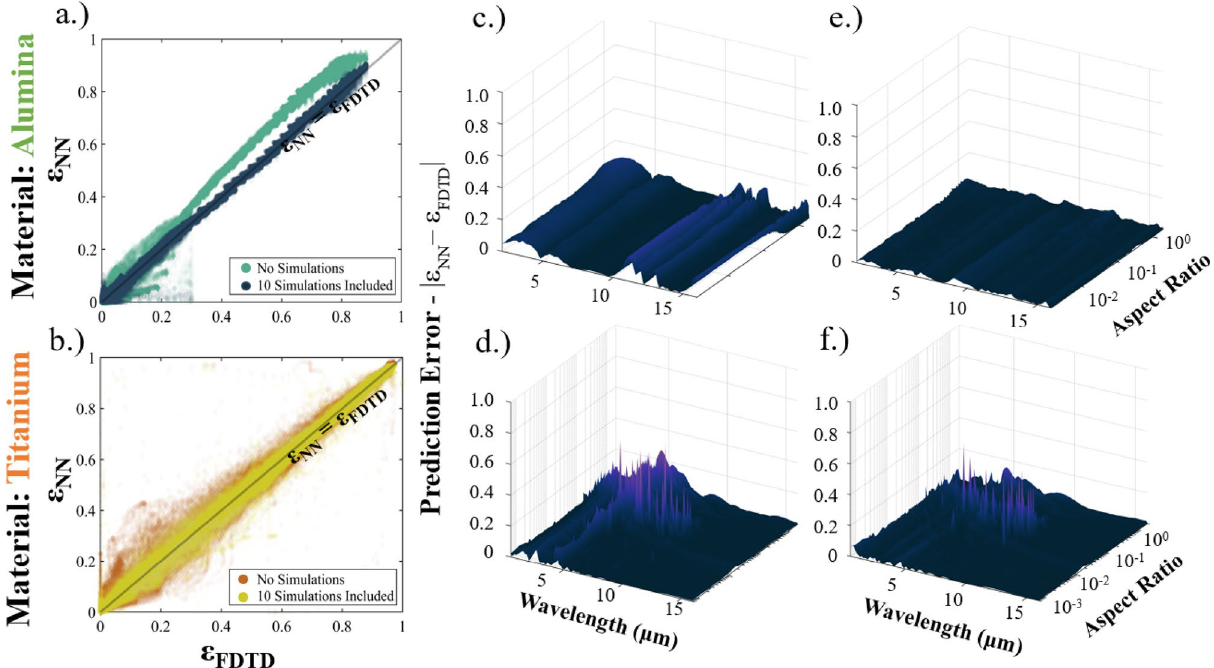
Figure 3. Neural-network predictions for two materials (Ti/Al2O3) that are not used in the in the training process. ( a , b ) The predicted optical properties vs. the FDTD computed properties, with and without 10 simulations included in training for alumina and titanium. Surface plot of the absolute error between prediction and simulation with no simulations included ( c , d ) and with simulations included in training. The wavelength is on the x-axis and the geometric information is visualized with the aspect ratio on the y-axis. Including 10 simulations (1% of the dataset) dramatically reduces the error in the alumina to a near zero value across all wavelengths and aspect ratios. For Ti, the resonance driven peaks in the low-aspect ratio structures are reduced and the error in all other sections becomes approximately optical spectra of micropyramids made of materials that are not included in the training process. We first test our network’s capacity to predict the optical properties of new materials with two new datasets: a metal (Titanium) 79 and a ceramic (Alumina, Al 2 O 3 ) 87 dataset comprised of 1500 simulations each. These materials are not used in the training or validation process, and they were explicitly chosen as Ti/Al 2 O 3 ’s complex refractive index values significantly differ from the materials used in training. Comparisons of the refractive indices used in training to those predict the titanium and alumina datasets are shown in the supplementary materials. These datasets were generated with the same methodology as before and each simulation has a unique combination of t sub , x span , and z span . After making predictions with a trained neural network that does not include any Titanium or Alumina data in training, we generate a different model that includes 10 randomly selected simulations from the alumina and titanium datasets (< 1% of the simulations) to compare the prediction accuracy when a small amount of data is included in the training process. Figure 3a,b plots the predicted optical properties by FDTD simulation vs the neural network predictions. The MAE between prediction and simulation for the alumina and titanium datasets are 0.0175 and 0.0131 respec- tively. Broken down by individual output, the MAE Reflectivity is (0.026, 0.0063) and MAE Tranmissivity is (6.01e−5, 0.028) for titanium and alumina respectively. The error in the reflectivity and transmission mirrors the results in Fig. 2b – metallic materials have reflection driven optical properties with geometry and show a very low error in transmission. Conversely, the relationship between the substrate thickness and extinction coefficient of alumina leads to non-zero transmission, with geometry playing a reduced role in determining the reflection and transmis- sion properties. In Fig. 3c,d we compare the absolute difference between the neural network and FDTD predicted emissivity for the alumina and titanium datasets. Across both the geometric and wavelength space, we observe a high degree of accuracy in the neural network predictions. The exception to this is a significant deviation in the titanium dataset (Fig. 3d) that occurs in a region with high material/geometry specific resonance. Similarly, the network minorly underpredicts the role of transmission in Al 2 O 3 , leading to the observed prediction differences. Despite these differences, the model is clearly able to differentiate material in a meaningful way and extrapolate accurately beyond the dataset used in training. To improve the prediction accuracy, we examine what occurs when we include a seemingly trivial amount of simulation data from the “unseen” materials in the training process. We select 10 simulations at random from the Ti and Al2O3 datasets (< 1%) and include them in the training/validation/test datasets. Figure 3a,b and Fig. 3e,f underscore that the small inclusion of data has a large impact on the prediction accuracy. The overall MAE score becomes (0.0073, 0.0049) while MAE Reflectivity improves to (0.014, 0.004) and MAE Tranmissivity improves to (7.69e−5, 0.0058) for titanium and alumina when 10 simulations of each are included in the training dataset.